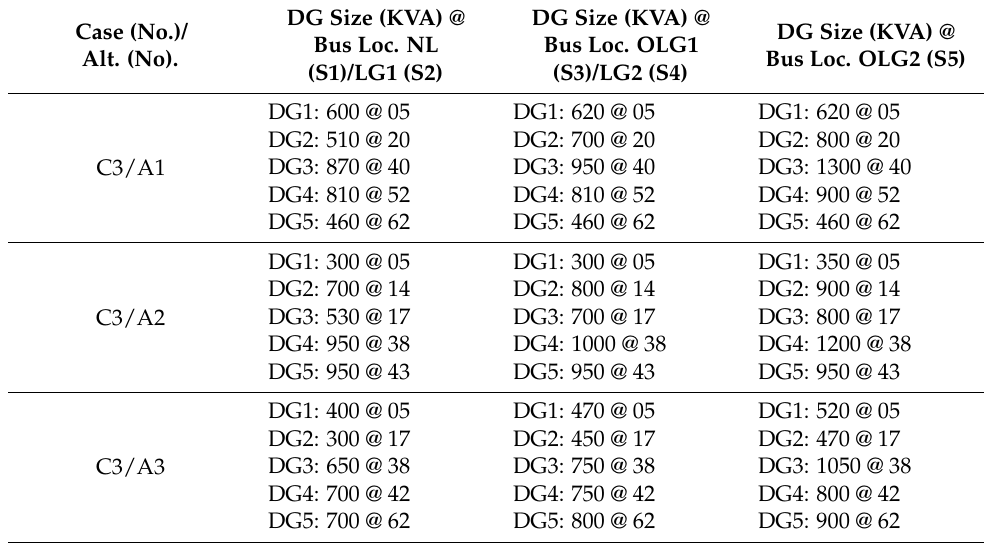
Table 13. DG sitting and sizing at 0.9 LPF for C3/S1–S5 across alternatives in the 65-bus MCMG.